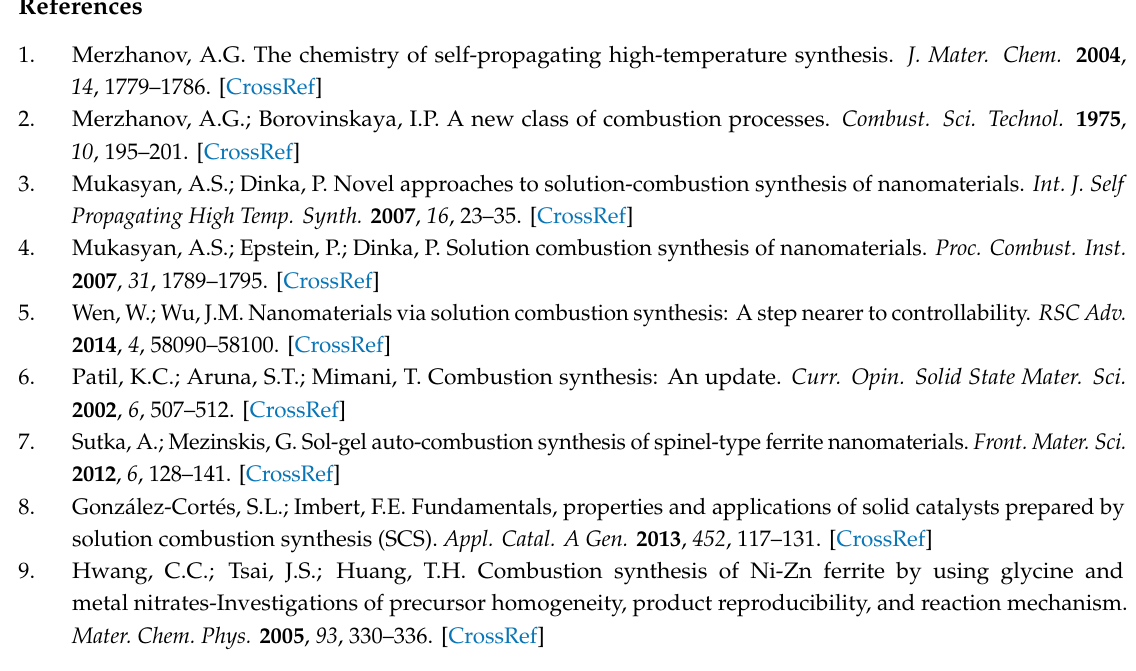
Figure S1: The synthesis of LaMnO 3 in the SHS regime: ( a ) ignition of precursor pellet; ( b ) and ( c ) layer-by-layer self-propagating high-temperature synthesis; ( d ) combustion product. Figure S2: The synthesis of LaMnO 3 in the VCS regime: ( a ) thin layer of precursor powder at the glass bottom; ( b ) volume combustion synthesis at 500 ◦ C heating; ( c ) and ( d ) combustion product. Table S1: Phase composition, coherent scattering domain size, and strain rate for combustion products formed in the di ff erent regimes calculated using the Topas V.4.2 software package. The standard deviation is indicated in brackets. Table S2: The comparison of ATR FTIR spectra of the Mn and Cr-containing glycine–nitrate precursors. Table S3: Enthalpy and heat capacity data used to estimate the adiabatic temperature. Table S4: Estimated thermodynamic data for combustion of